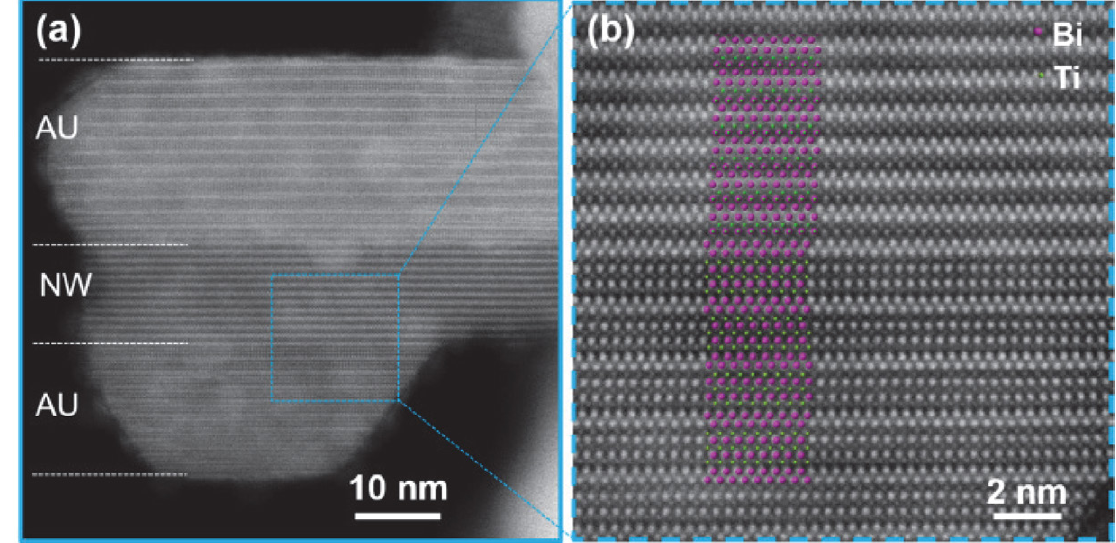
Figure 9. HAADF STEM images of a BIT particle from the NW sample annealed for 2 hours at 525 °C. The particle is composed of a NW sandwiched between two lamellas with the Aurivillius (AU) structure ([010] NW ||[110] AU ). Projected models of the AU structure and the NW structure are super- imposed over (b) to illustrate the positions of the Bi 2+ and Ti 4+ ions. ( Reproduced from the publication by D. Makovec, N. Križaj, A. Meden, G. Dražić, H. Uršič, R. Kostanjšek, M. Šala, S. Gyergyek, Nanoscale 2022, 14, 3537–3544 with permission from The Royal Society of Chemistry. 53